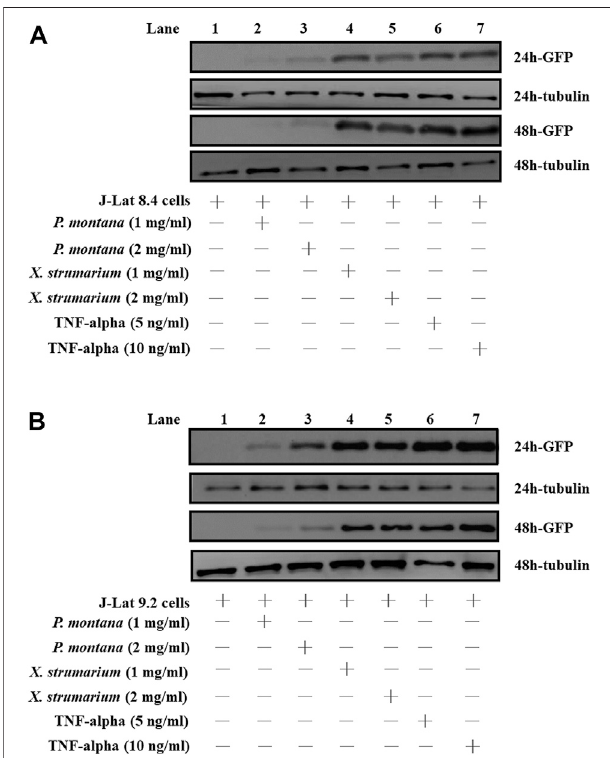
FIGURE 2 | Effect of P. montana and X. strumarium on protein expressions under the control of HIV-1 5 ′ - LTR in J-Lat cells, respectively. (A) J-Lat 8.4 cells and (B) J-Lat 9.2 cells were treated with herbal extracts for 24 and 48 h, respectively. J-Lat cells only were served as the negative controls (Lane 1). P. montana treated J-Lat cells were served as the experimental group (Land 2, P. montana (1 mg/ml); Lane 3, P. montana (2 mg/ml)). X. strumarium treated J-Lat cells were also served as the experimental group (Lane 4, X. strumarium (1 mg/ml); Lane 5, X. strumarium (2 mg/ml)). TNF-alpha (5 and 10 ng/ml) treated J-Lat cells were served as the positive controls (Lanes 6 and 7). The un-treated and treated cell lysates were then resolved by SDS-PAGE and Western blot